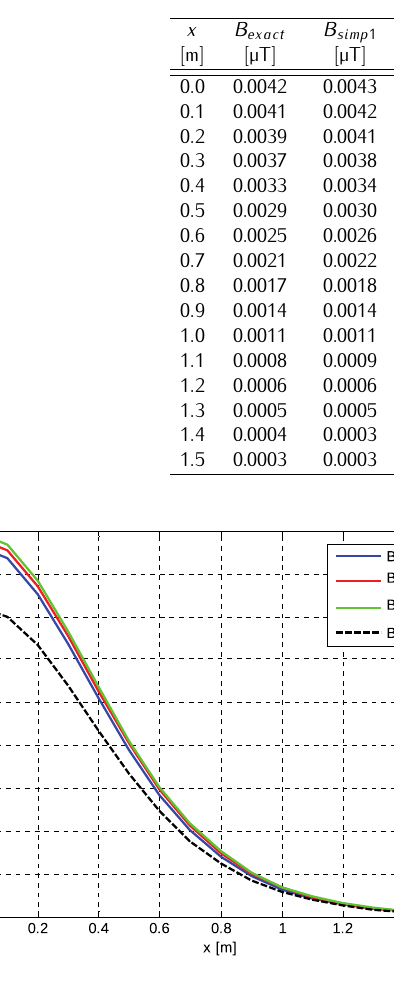
Figure 6. B exact , B simp 1 , B simp 2 , B lit at ground level vs. horizontal distance x from the orthogonal projection of the cable axis on the ground plane for the cable ARE4H1RX 12/20 kV 3 × 120 mm 2 in underground line configuration at a depth of 0.80 m in linear coordinates. (underground line configu- ration at a depth of 0.80 m).